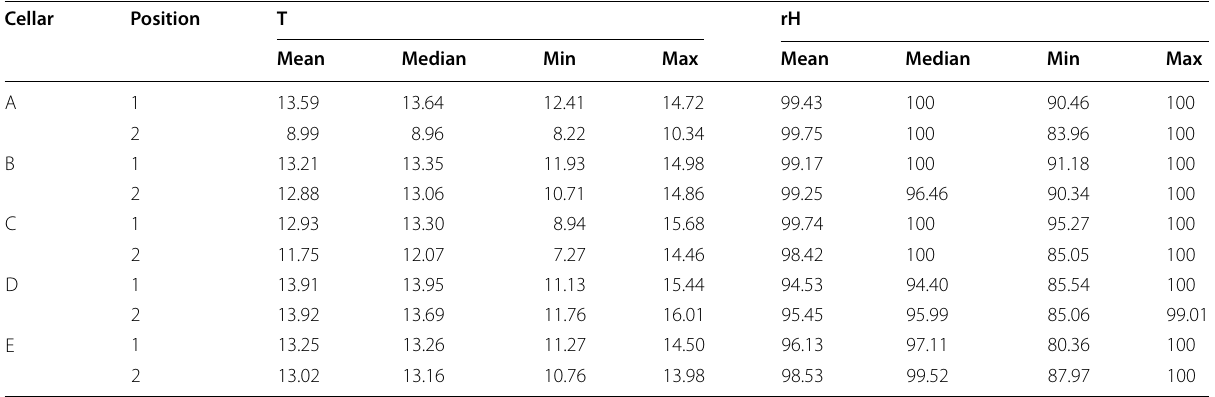
Table 2 Temperature (T, °C) and relative humidity (rH, %) measured in the cheese ripening cellars during the study period. Dataloggers were placed in two locations in each cellar (approx. 5 m from each other)